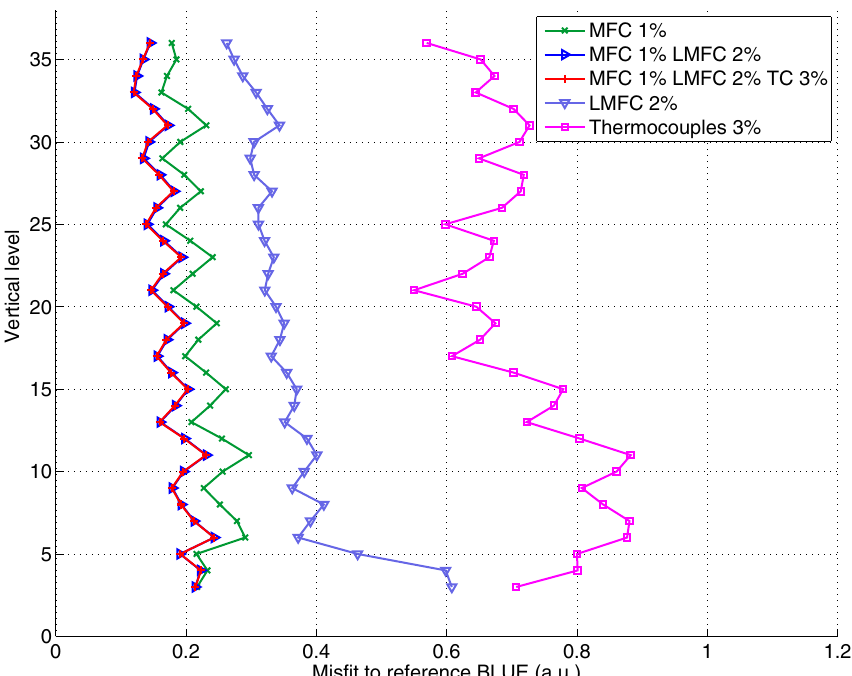
Fig. 5. Axial mis fi t for various kind of instrumental con fi gurations, measured by the RMS of the difference between the analysis and the reference